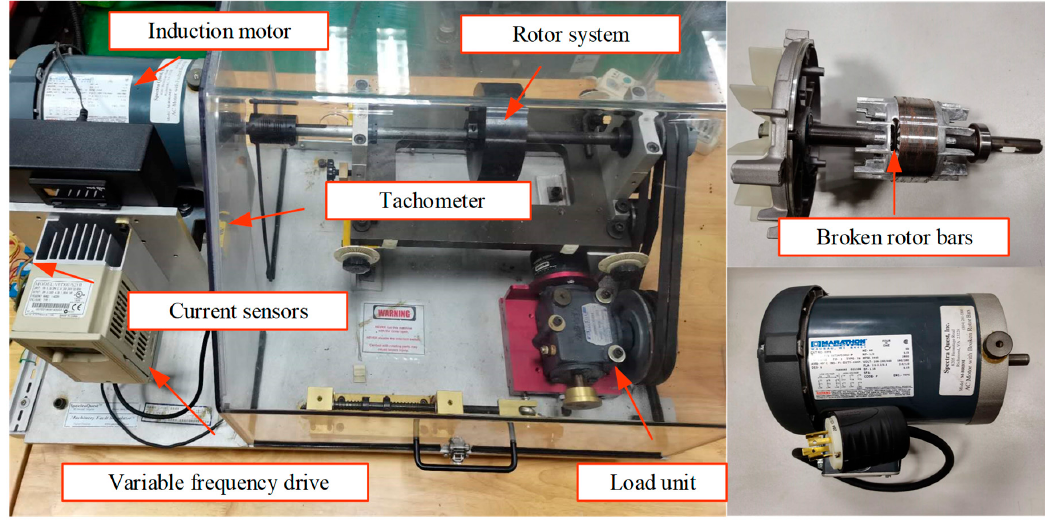
Figure 2. Mechanical fault simulator and its faulty motor.